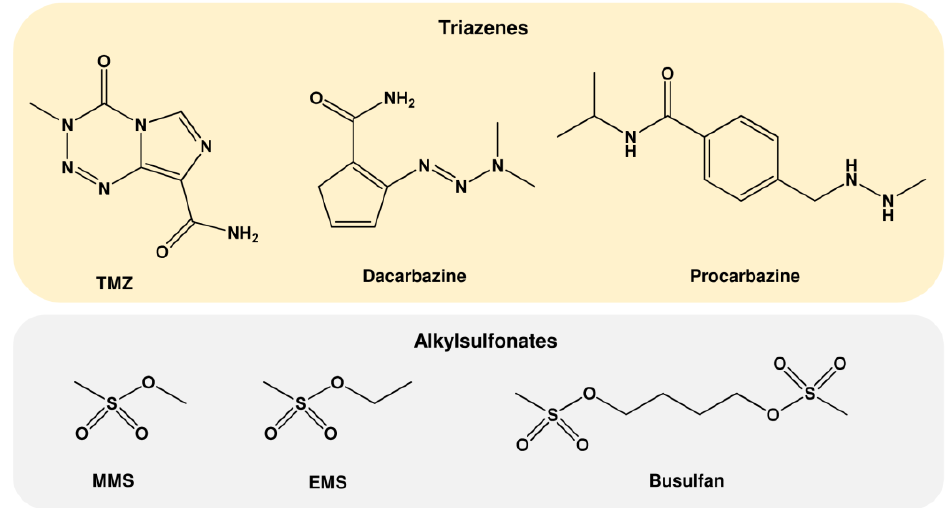
Figure 5. Chemical structure of further alkylating agents. TMZ: temozolomide; MMS: methyl methanesulfonate; EMS: ethyl methanesulfonate.